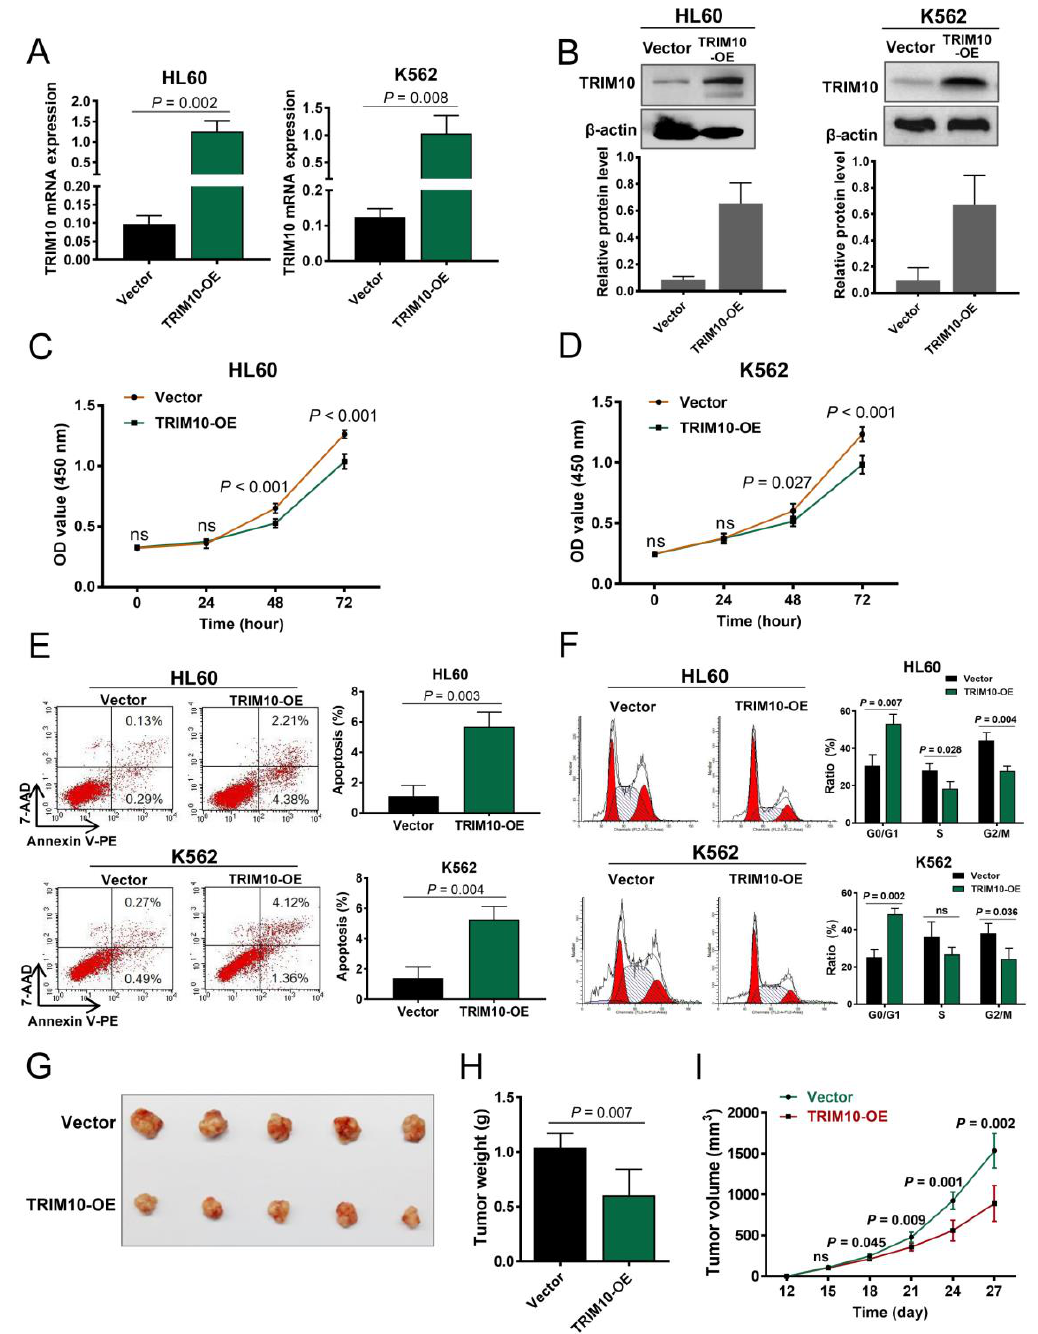
Figure 3. Overexpression of TRIM10 inhibited AML cell proliferation. ( A , B ) qRT-PCR and Western blots confirm an evident increase of TRIM10 in HL60 and K562 AML cell lines, with empty vector transduced in the controls. ( C , D ) Growth curves of HL60 empty vector, HL60 TRIM10-overexpressing (OE), K562 empty vector, and K562 TRIM10 OE AML cell lines by measuring optical density (OD) value at 450 nm using CCK-8 analysis. ( E ) Analysis of apoptosis with PE-Annexin V/7-AAD staining in HL60 TRIM10 OE, K562 TRIM10 OE and their empty vector AML cell lines after transduction for 48 h. ( F ) The percentages of cell cycle phases in HL60 TRIM10 OE, K562 TRIM10 OE and their empty vector AML cell lines. ( G – I ) TRIM10 overexpression exhibits AML cell inhibition in vivo: ( G ) comparison of tumor nodes between TRIM10-overexpressing HL60 cells (TRIM10-OE, n = 5) and HL60 cells transfected with empty vector (Vector, n = 5); ( H ) tumor volumes between TRIM10 and Vector groups in B-NDG mice; ( I ) tumor weight between TRIM10 and Vector